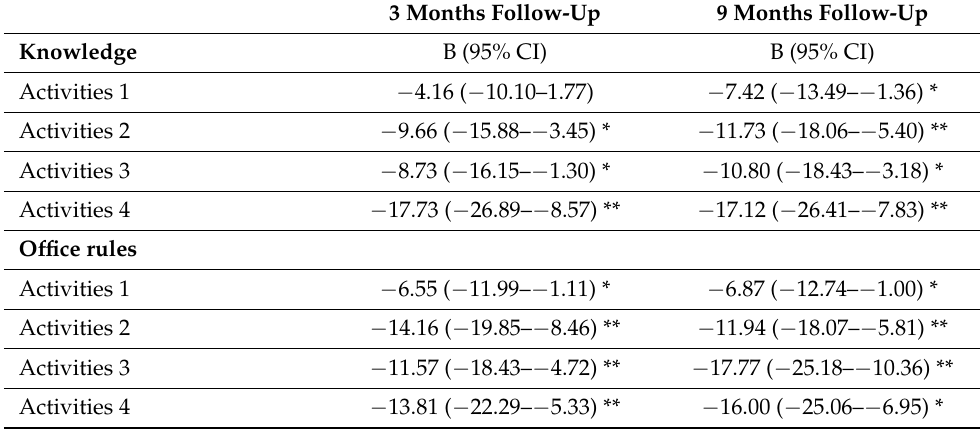
Table 4. Dose—response effects of participation in process activities on changes in satisfaction with knowledge, office rules, information and support three and nine months after relocation. Estimates (B) show the change in satisfaction in the participation groups compared with the change in